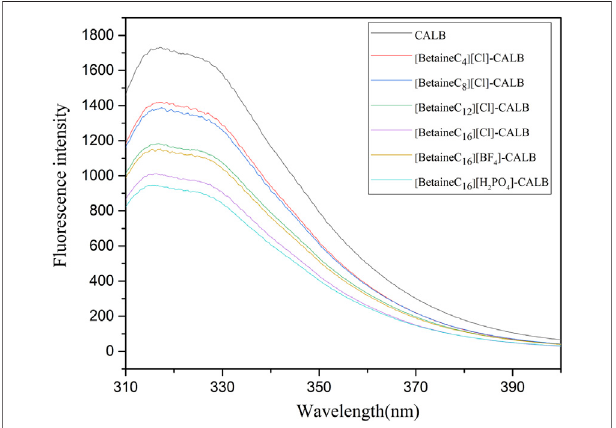
FIGURE 6 | Fluorescence spectra of native and modi fi ed